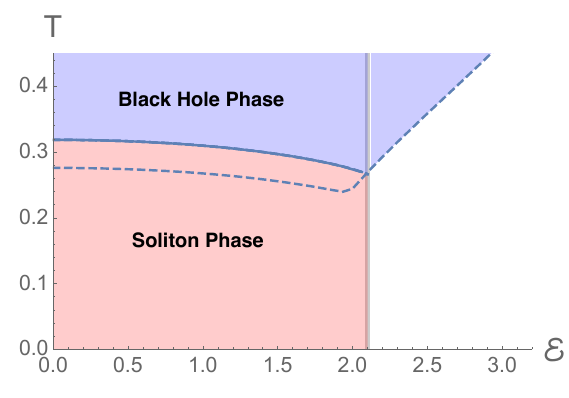
Figure 18. Phase diagram with the critical temperature (solid blue curve) above which the black hole phase is thermodynamically favoured. The dashed line shows the minimum temperature of the L1 black hole, and the vertical gray line marks the maximum electric (cid:12)eld for the